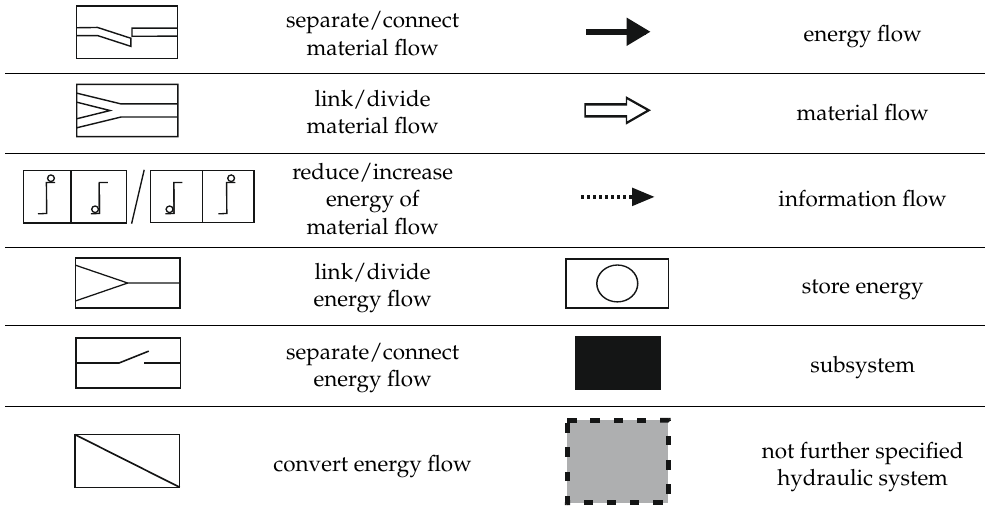
Table 1. Symbols of generally valid functions in accordance with reference [9].